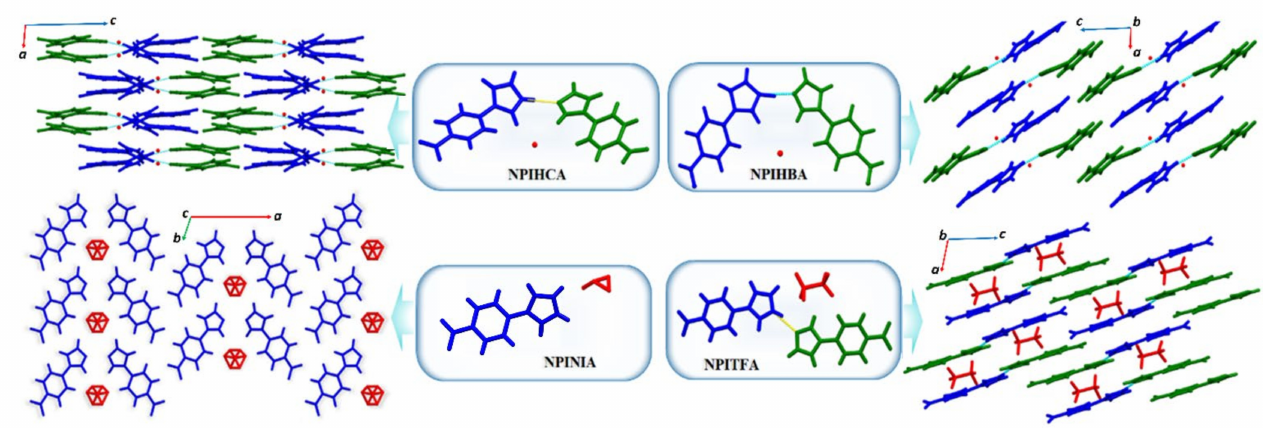
Figure 4. Chemical composition and crystal packing for ICCs involving